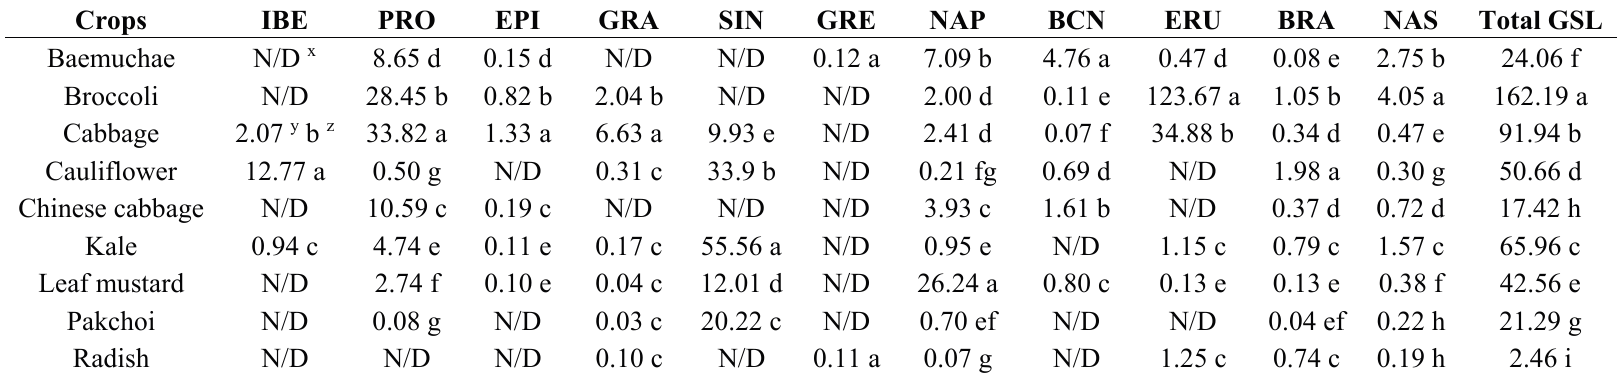
x N/D: Not detected; y Values are the means of three independent replications; z Different letters within a column indicate statistically significant by Duncan’s multiple-range test at p ≤ 0.05. Table 3. Glucosinolate concentration (µmol·g − 1 dry weight) in sprouts of nine Brassica vegetables.